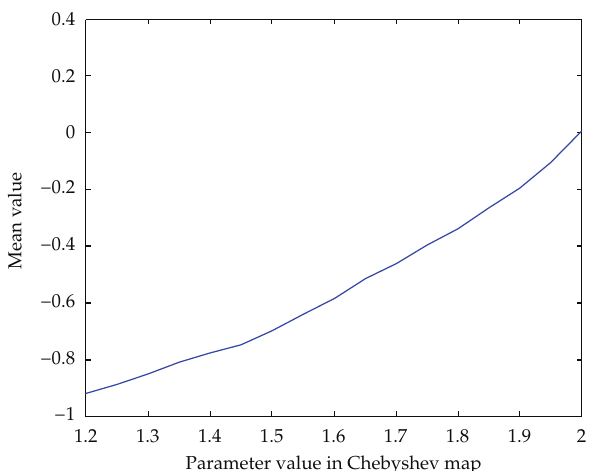
Figure 1: Mean value estimation M (cid:2) θ (cid:3) of chaotic sequence generated by Chebyshev map with di ff erent parameters (cid:2) parameter sampling length is 0.05 (cid:3)